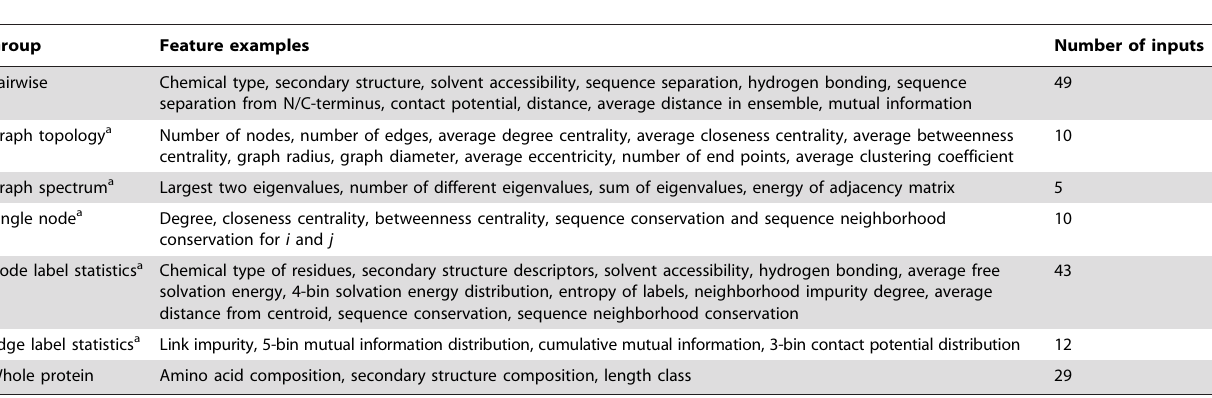
a Graph-based features.